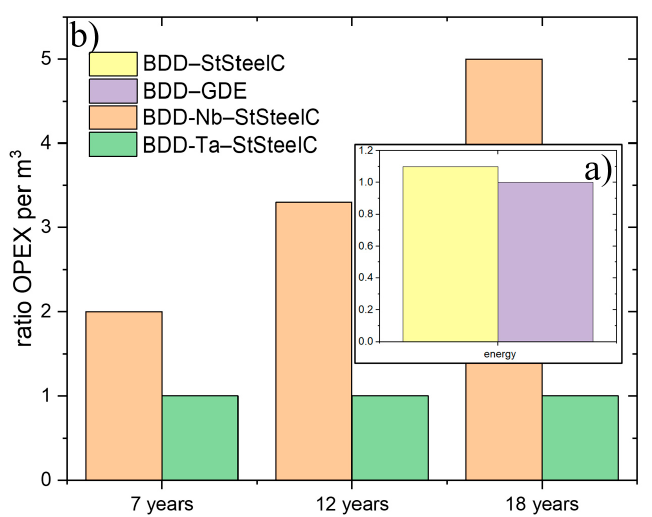
Figure 6. Operational expenses for the case study related to ( a ) energy and ( b ) electrode replacement costs for EAOP ® cell configurations. StSeelC, BDD-Nb and BDD-Ta denotes stainless steel cathode, boron–doped diamond on niobium substrate and boron–doped diamond on tantalum substrate, respectively.